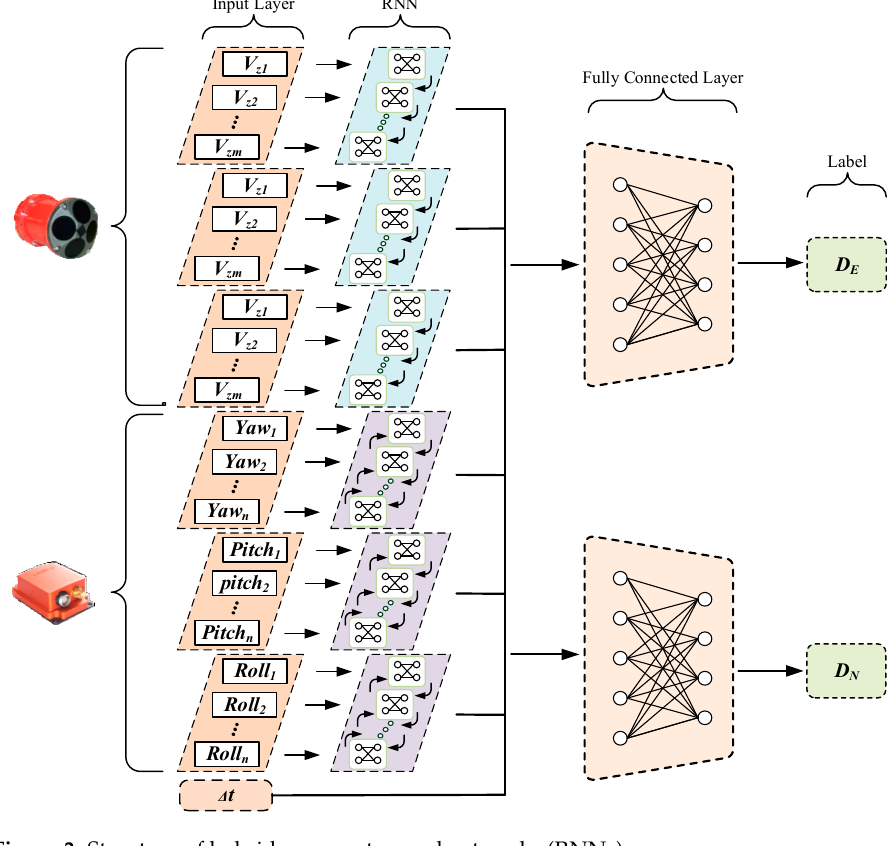
Figure 3. Structure of hybrid recurrent neural networks (RNNs).